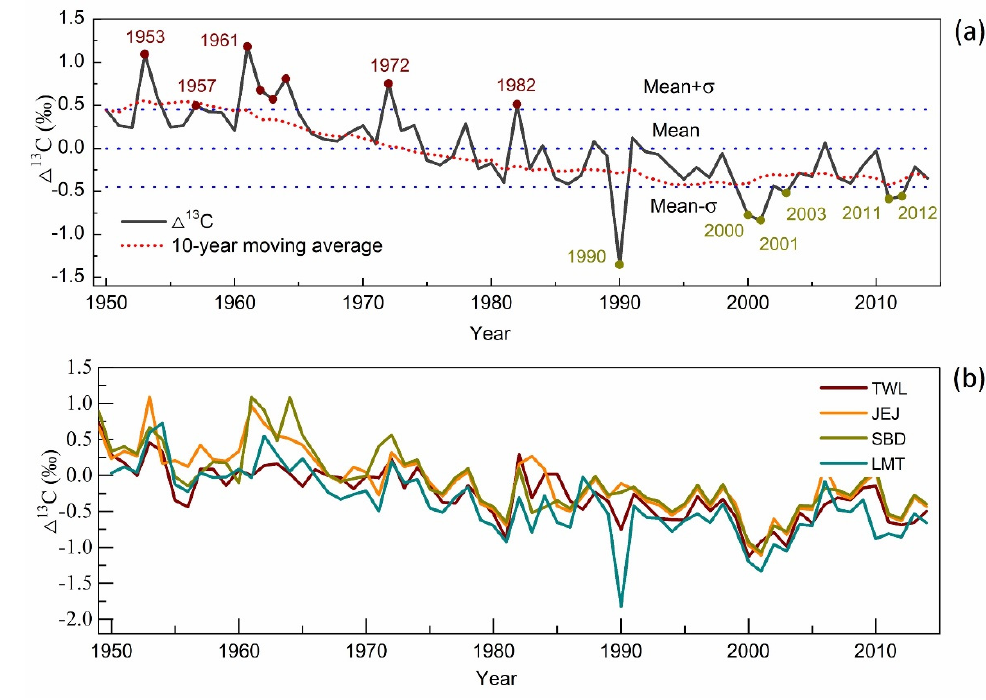
Figure 3. ( a ) The composite tree-ring ∆ 13 C chronology of Tajikistan. The thick red dotted line represents the 10-year moving average. The rufous and khaki dots represent the highest and lowest values, respectively; ( b ) Interannual patterns of ∆ 13 C chronologies from the different sites. All the chronologies were centered to zero.